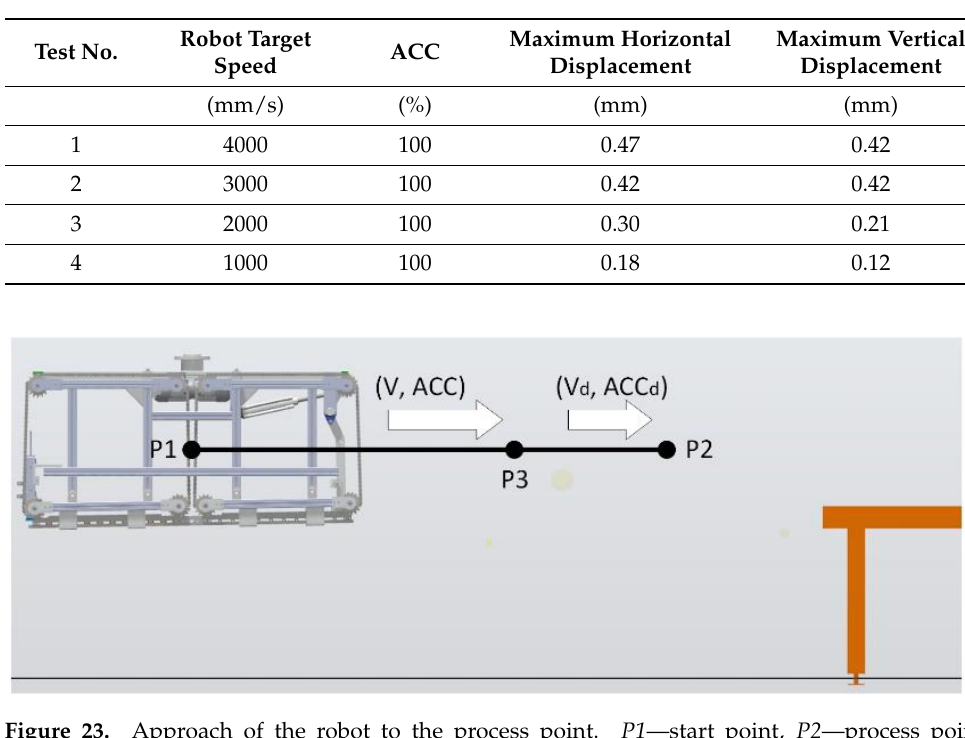
Table 4. Maximum gripper displacement for selected robot speeds. Test No.